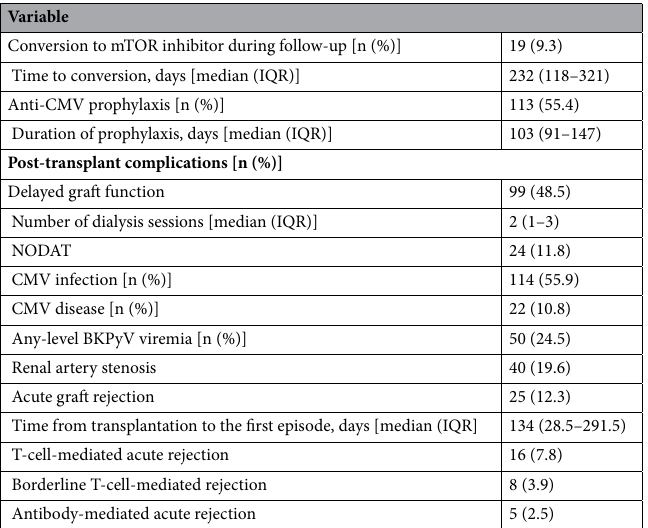
Table 2. Demographics and clinical characteristics of the study cohort (n = 204). ATG antithymocyte globulin; BKPyV BK polyomavirus; CMV cytomegalovirus; D donor; DBD donation after brain death; DCD donation after circulatory death; HCV hepatitis C virus; HIV human immunodeficiency virus; HLA human leukocyte antigen; IQR interquartile range; MMF/MPS mycophenolate mofetil/mycophenolate sodium; mTOR mammalian target of rapamycin; NSAID nonsteroidal anti-inflammatory drug; R recipient; SD standard deviation; NODAT new-onset diabetes after transplantation. a Data on body mass index of the recipient was not available for 17 patients. b Data on the HCV serostatus was not available for 5 patients. c Data on the HIV serostatus was not available for 2